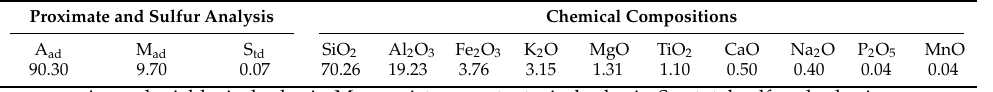
Table 2. Contents (wt %) of coal gangue samples in the Wulantuga open-cast coal mine area. Proximate and Sulfur Analysis Chemical